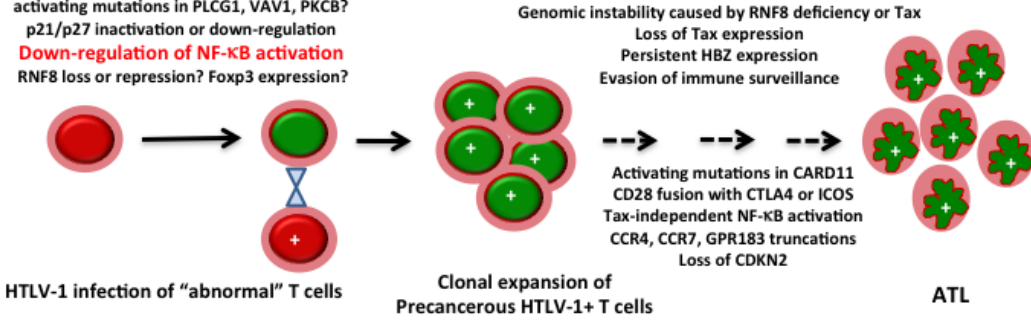
Figure 3. A model for adult T-cell leukemia/lymphoma (ATL) development. Loss of senescence response and/or inhibition or down-regulation of NF-κB activation (cells marked with green nuclei) drives clonal expansion of HTLV-1-infected cells (each marked with a “+” sign). Some of these cells, presumably precancerous, continue to evolve, propelled by the genomic instability caused by either Tax or the loss of RNF8, eventually giving rise to ATL. The frequent genetic alterations detected in ATLs, such as activating point mutations in phospholipase Cγ1 (PLCG1), vav guanine nucleotide exchange factor 1 (VAV1), and protein kinase Cβ (PKCB), activating point mutations and deletions in caspase recruitment domain-containing protein 11 (CARD11), CTLA4/CD152–CD28, and inducible T-cell COStimulator (ICOS)/CD278–CD28 fusions, homozygous deletion of cyclin-dependent kinase inhibitor 2A (CDKN2), and chemokine (C-C motif) receptor 4 (CCR4), CCR7, and G protein-coupled receptor 183 (GPR183) truncations, are incorporated into this model to stimulate discussions and suggest future experiments.